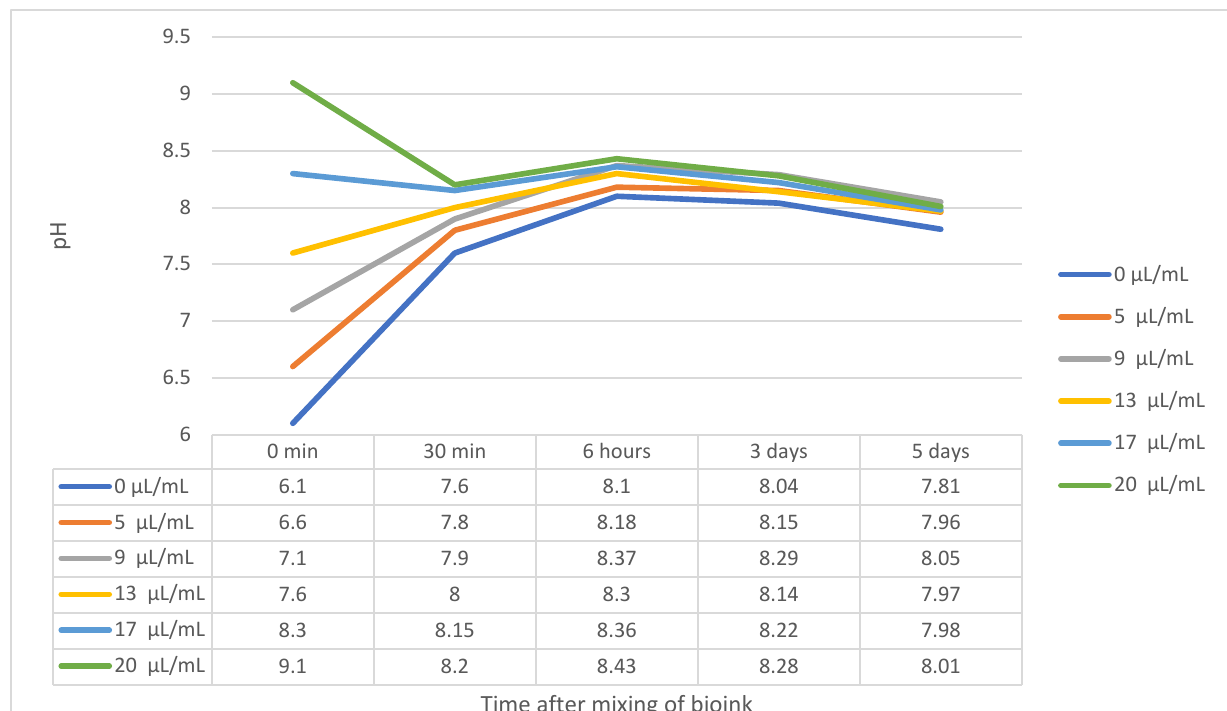
Figure 4. Sample pH drift. Immediately after mixing the bioink, the pH ranged from 6.1 (sample 0) to 9.1 (sample 20). However, after crosslinking the bioinks, the values became more and more alkaline, and the difference between the extremes was not so high anymore. After 3 days of cultivation, the gels became more acidic due to cell metabolism. The pH differences between the samples, especially after 5 days of cultivation, were very small and statistically insignificant. This phenomenon was caused by buffers (NaHCO 3 ) in the culture medium, which was a component of the bioinks.